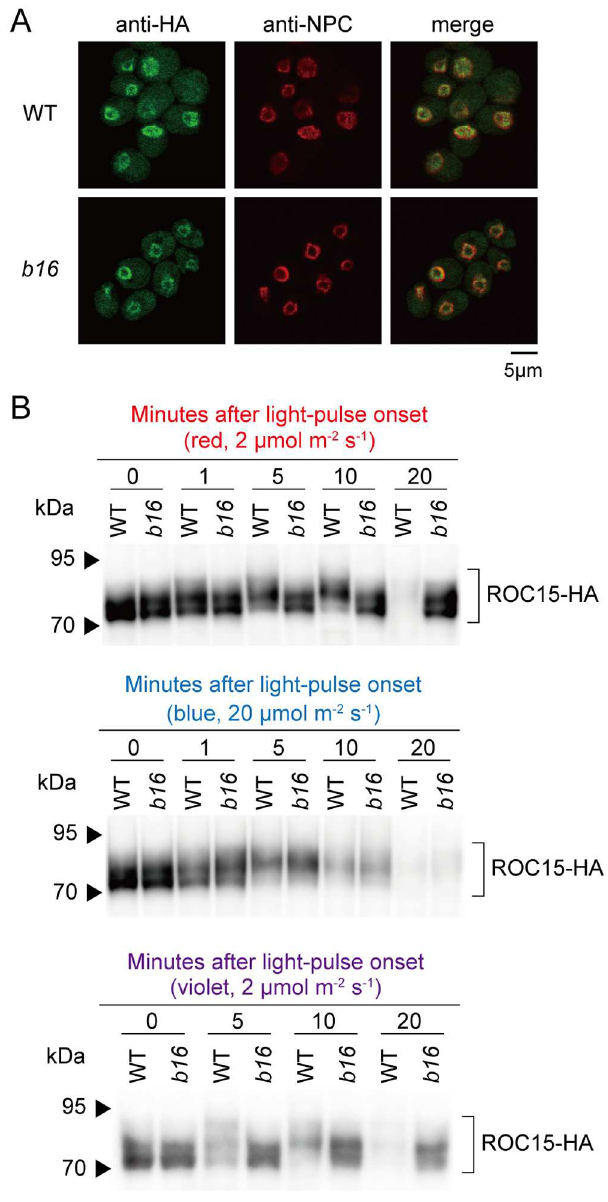
Fig 4. Subcellular localization and phosphorylation of ROC15. The b16 strain (mt + ) was genetically crossed with the ROC15-HA strain (mt - ). A progenyharboring b16 mutation and ROC15-HA transgene was selectedby spot tests for antibioticresistanceand genomicPCRs. The hygromycin-resistanceis genetically linkedto b16 (see S5 Fig). LD-synchronized cultures of the progenyin HS liquidmedium were used. (A) Cells were harvestedat midnight and subjectedto immunocytochemistry. The nuclear membranewas counterstained using an antibody againstthe nuclear pore complex(NPC). Photographs obtainedunder the same settings of microscope and detector are shown. (B) Cells were exposedto a 0.5 min pulse of red (660 nm, 2 μ mol (cid:1) m -2 (cid:1) s -1 ), blue (470 nm, 20 μ mol (cid:1) m -2 (cid:1) s -1 ), or violet light (405 nm, 2 μ mol (cid:1) m -2 (cid:1) s -1 ) at midnight, and total protein extracts were subjectedto Western blot